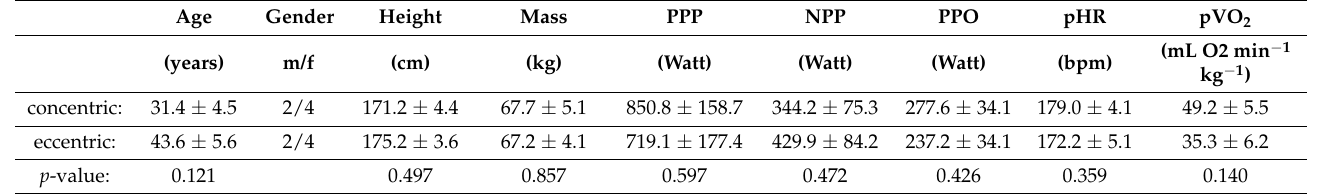
Table 2. Physiological characteristics at baseline. Mean ± SE of the assessed physiological parameters and peak oxy- gen uptake. Repeated-measures ANOVA with a post-hoc test of least significant difference. PPP, positive peak power; NPP, negative peak power, pHR; peak Heart rate, pVO 2 ; peak VO2max; m, male; f,